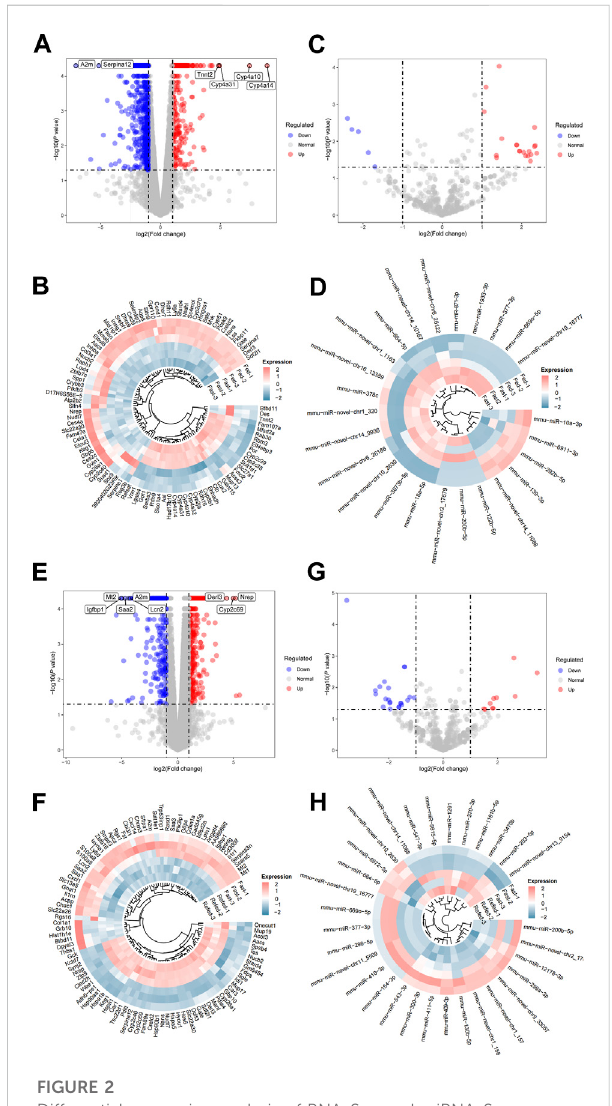
FIGURE 2 Differential expression analysis of RNA-Seq and miRNA-Seq datasets. (A,B) Hepatic DEGsduring thetransition fromfedto fasted in mice. (A) VolcanoplotofDEGsintheliversofmiceinfastedcompared with fed state. The top DEGs are labeled as indicated. (B) Heatmap showing expression patterns between top 100 DEGs in the liver of mice in fasted compared with fed state after batch-effect correction. (C,D) Hepatic dysregulated miRNAs during the transition from fed to fastedin mice. (C) Volcano plot of dysregulated miRNAs in the liver of mice in fasted compared with fed state. (D) Heatmap showing expression patterns between dysregulated miRNAs in the liver of mice in fasted compared with fed state after batch-effect correction. (E,F) Hepatic DEGs during the transition from fasted to refed state. (E) Volcano plot of DEGs in the liver of mice in refed compared with fasted state. (F) Heatmap showing expression patterns between top 100 DEGs in the liver of mice in refed compared with fasted state after batch-effect correction. (G,H) Hepatic dysregulated miRNAs during the transition from fasted to refed state. (G) Volcano plot of dysregulated miRNAs in the liver of mice in refed compared with fasted state. (H) Heatmap showing expression patterns between dysregulated miRNAs in the liver of mice in refed compared with fasted state after batch-effect correction.